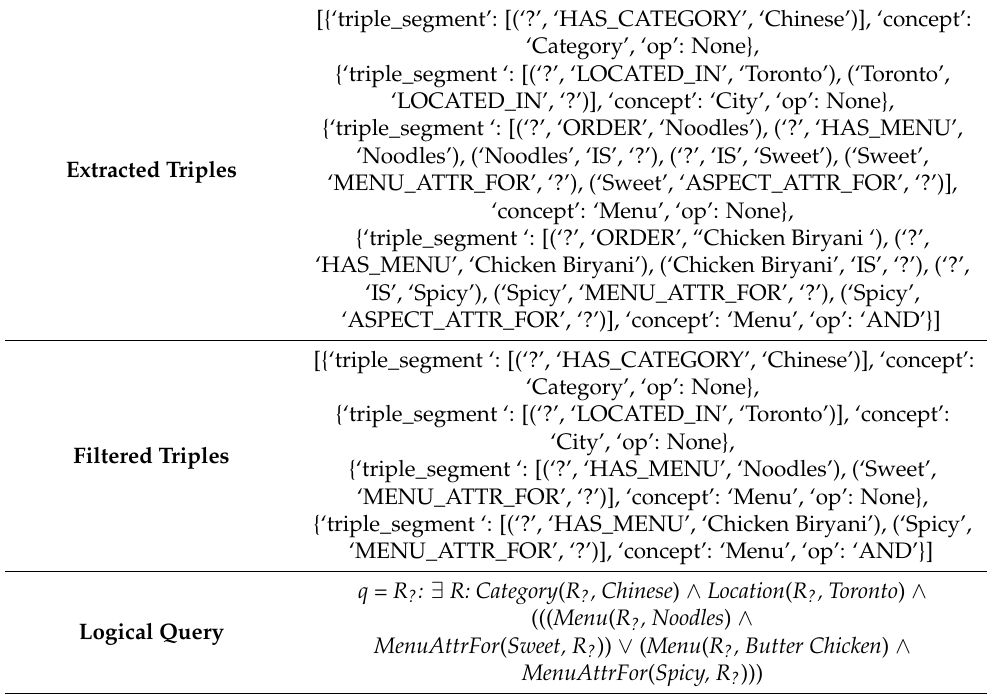
Table 2. Results of user query “ Recommend best Chinese restaurant in Toronto which serves sweet Noodles or spicy Chicken Biryani ” conversion to logical